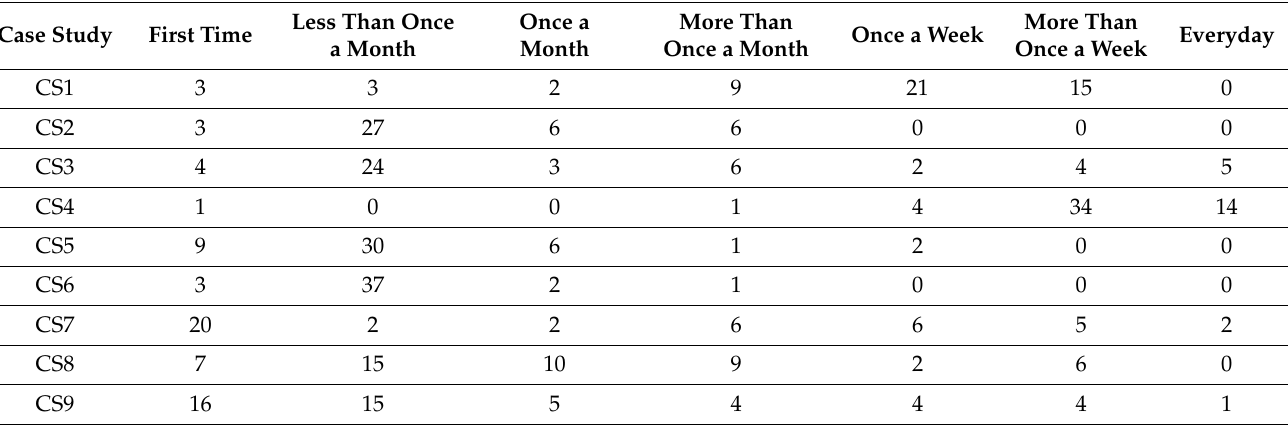
Table A5. Table illustrating the frequencies of the frequentation of the facility for each single case study (CS1–CS9). Own